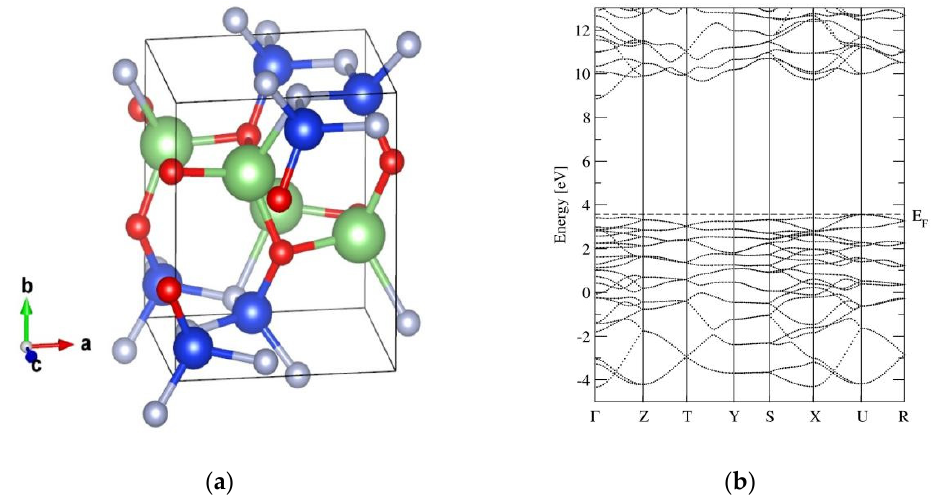
Figure 1. ( a ) The crystal structure and ( b ) the band structure of α -LiSiON. The green, blue, red, and gray spheres represent Li, Si, O, and N atoms, respectively.